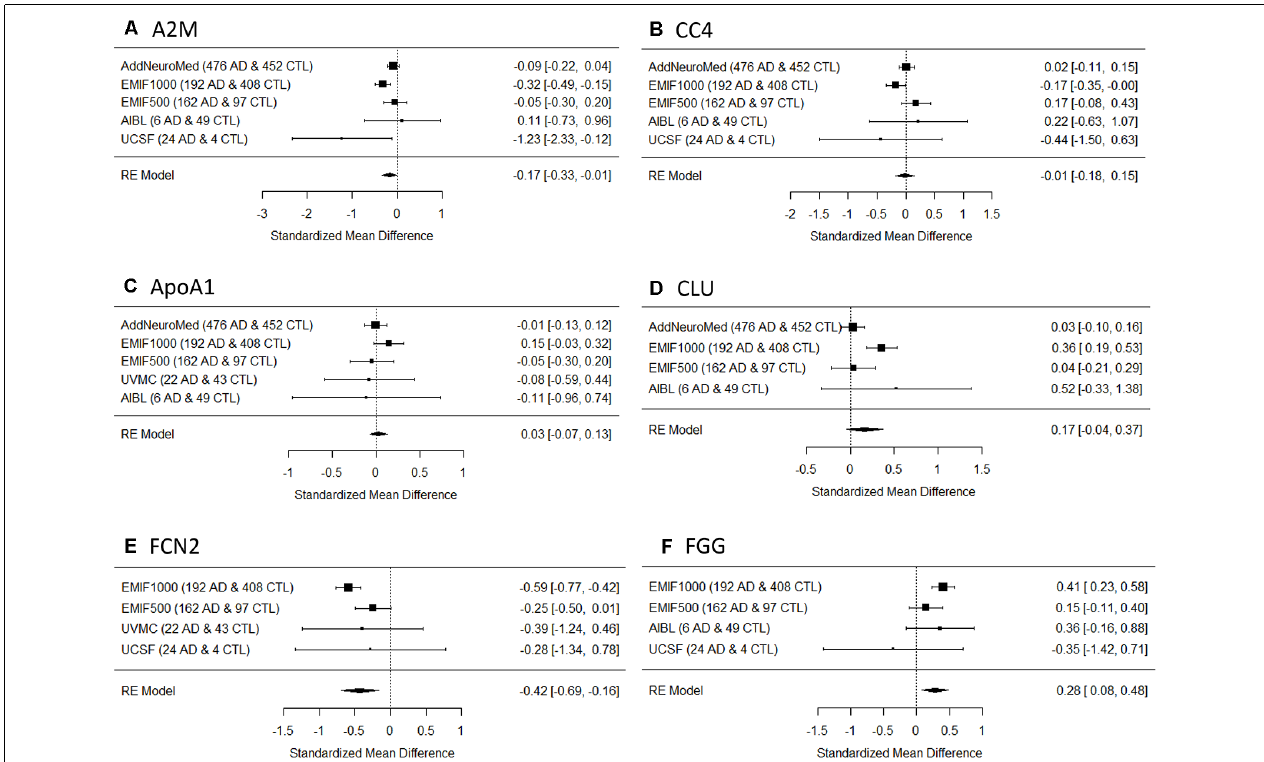
FIGURE 1 | Forest plot of six proteins between Alzheimer’s disease (AD) and controls. RE, random effect; (A) A2M, alpha-2-macroglobulin; (B) CC4, complement component 4; (C) ApoA1, apolipoprotein A-I; (D) CLU, clusterin; (E) FCN2, ficolin-2; (F) FGG, fibrinogen gamma chain; EMIF, European Medical Information